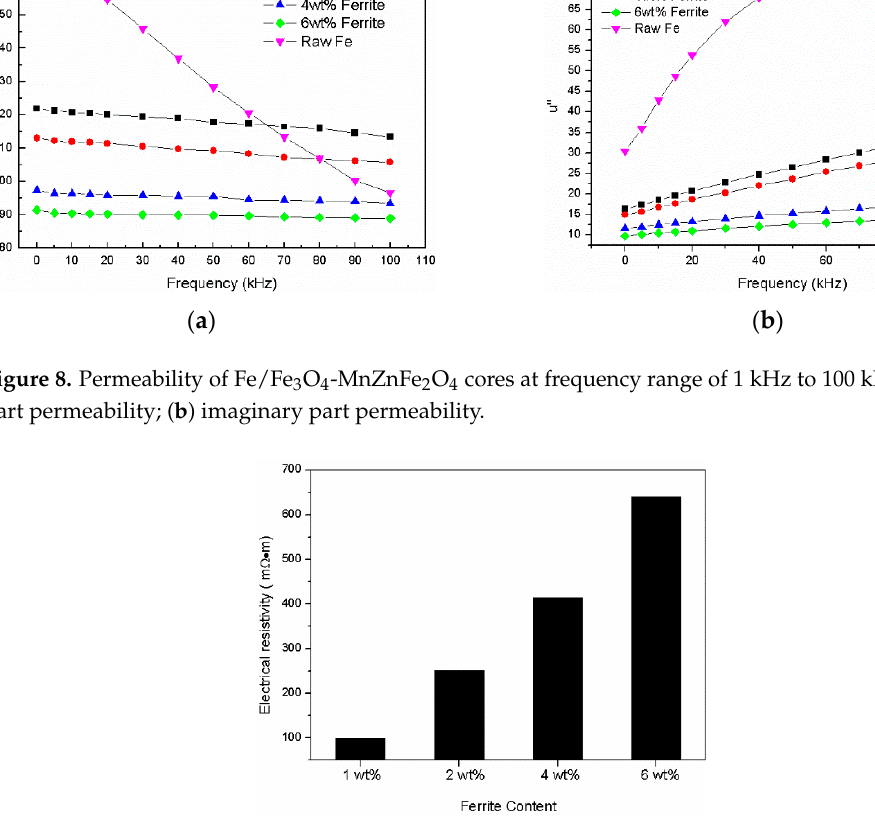
Figure 9. Resistivity of the composite compacts with different ferrite contents.